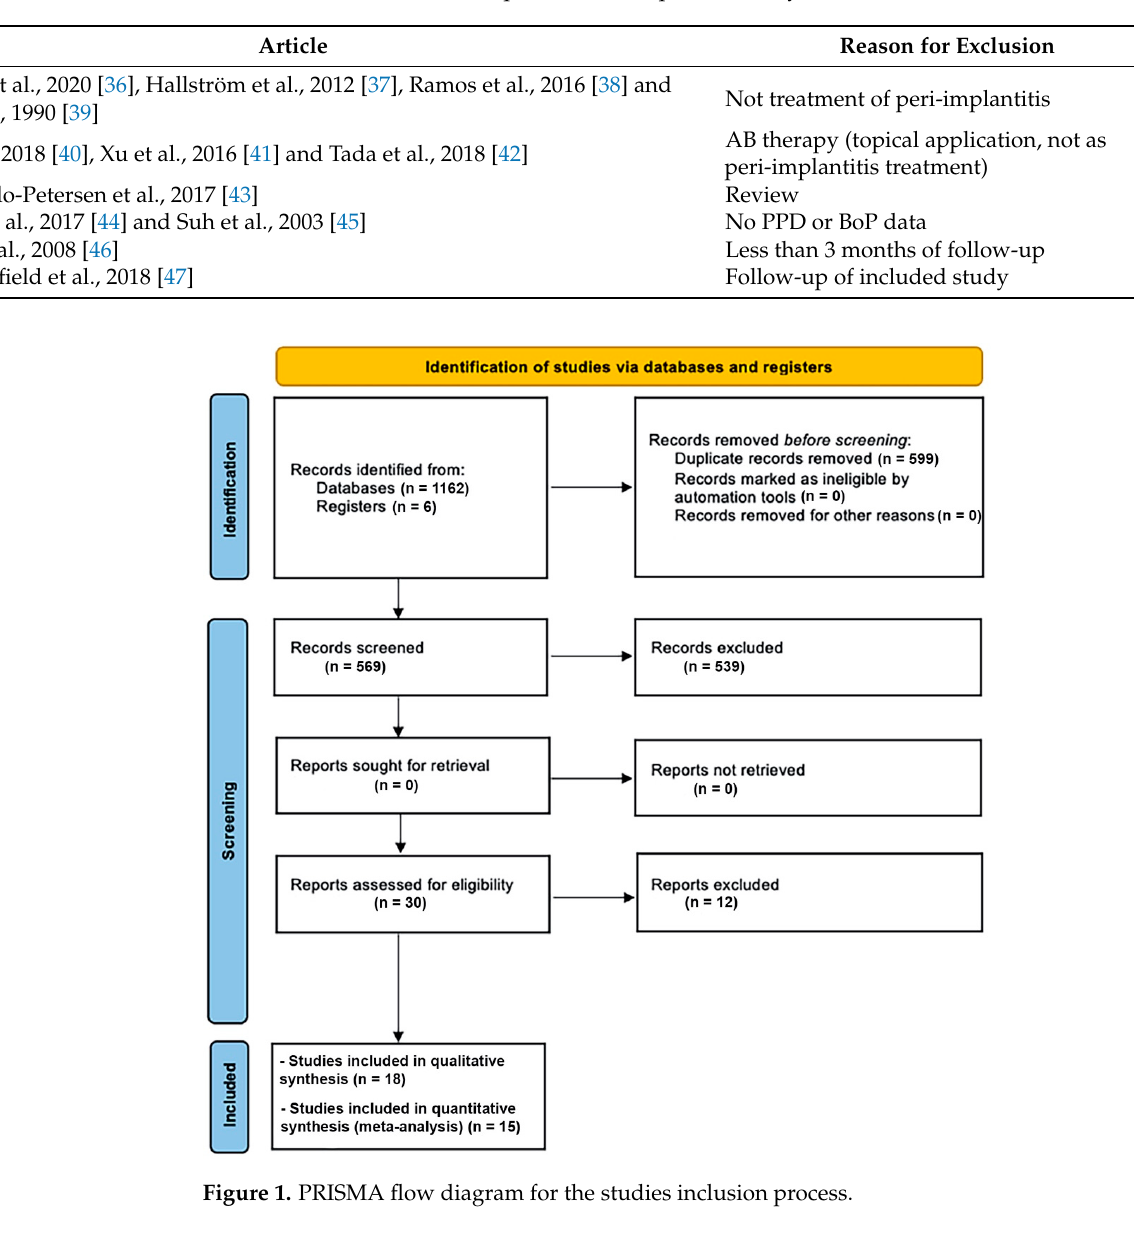
Table 1. Excluded studies for qualitative and quantitative synthesis with reasons.